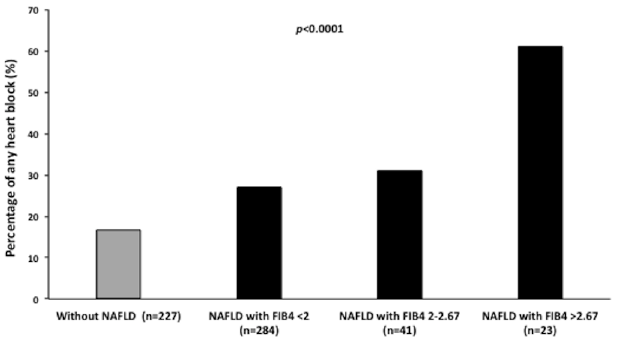
Fig 3. Prevalence of heart block in relation to advanced NAFLD fibrosis. Prevalenceof any heart block (combined endpoint)in patients without NAFLD (gray column; n = 227) and in patients with NAFLD (black columns; n = 348) stratified by fibrosis (FIB)-4 score. P -value < 0.001for the unadjusted trend. This trend remained statistically significanteven after adjustmentfor age, sex, BMI, hemoglobin A1c, eGFR, macroalbuminuria,hypertension, prior ischemicheart diseaseand mild-to-moderate valvularheart disease. Data on FIB-4 score were available only in 348 patients with NAFLD.